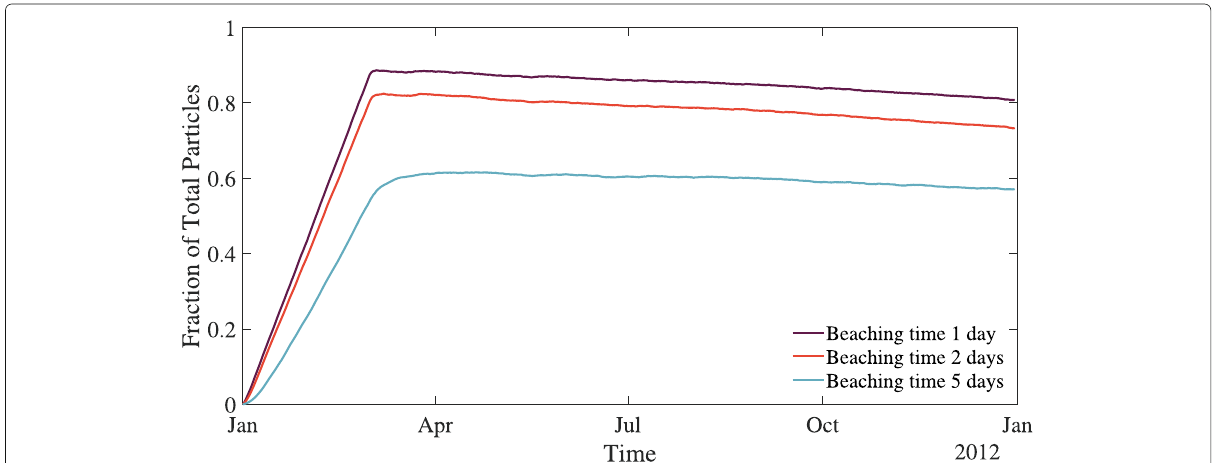
Fig. 2 Comparison of influence of three values of T b on the fraction of beached particles for the model run with no beach type dependence (NBD). Residence time for plastic on the beach was fixed at T b = 69 days for all three